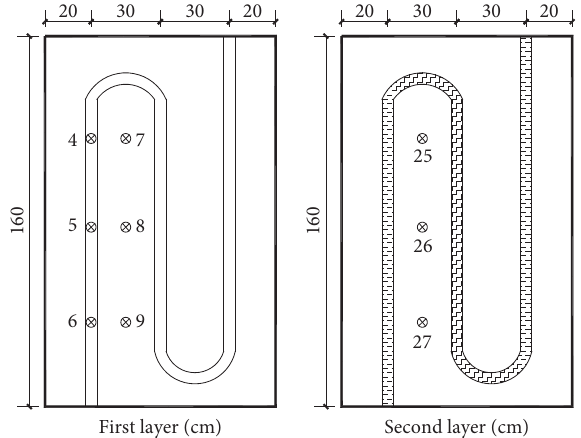
Figure 7: Arrangement of temperature measuring points. Table 2: Temperature rise experiment group.